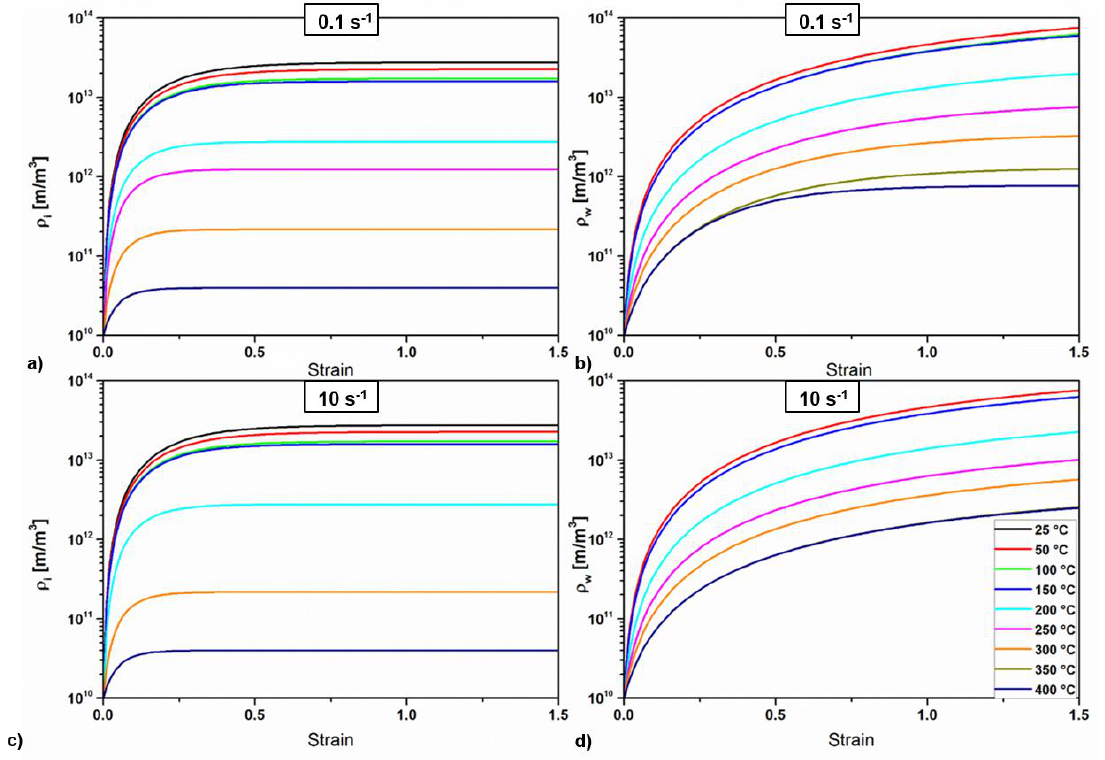
Figure 5. Modelled dislocation densities and subgrain size developed during deformation at room temperature and 10 s − 1 of strain rate. Experimental data from Reference [25] show good correlation with the literature.